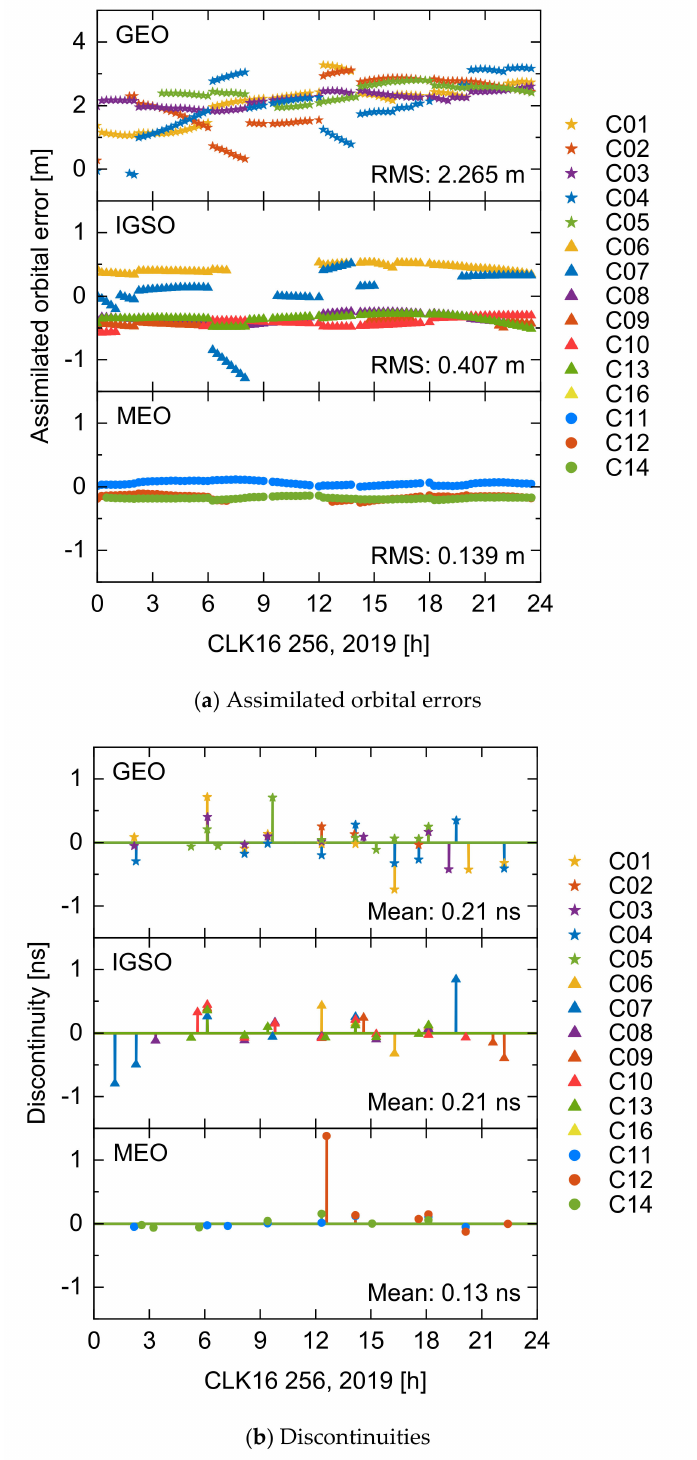
Figure 3. Assimilated orbital errors ( a ) and discontinuities ( b ) for CLK16 on day of year 256,